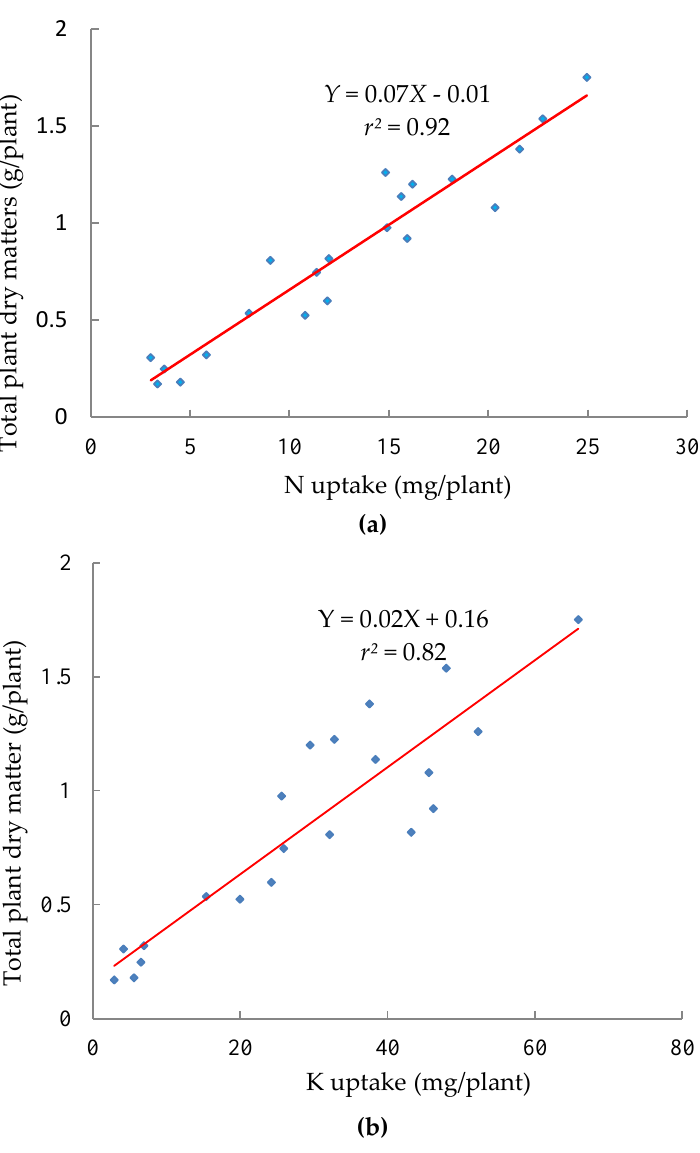
Figure 3. Relationship between N uptake and total dry matter of Chinese cabbage of the second planting in the Leilehua Ultisol soil ( a ). Relationship between K uptake and total dry matter of Chinese cabbage of the second planting in the Leilehua Ultisol soil ( b ).